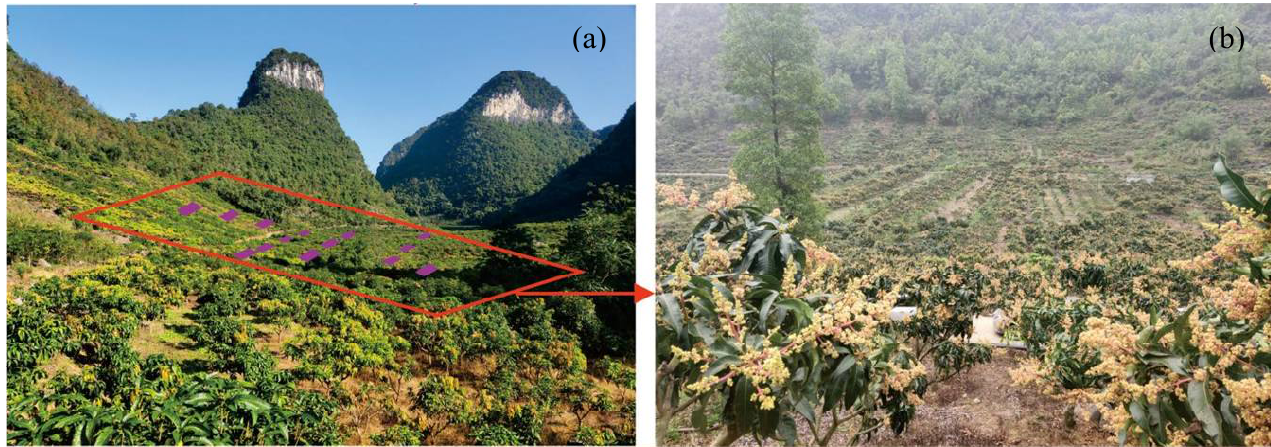
Figure 1. Schematic diagram of the study area. The purple blocks in the image (a) are the sampling sites in the different geomorphic parts (depressions and non-depressions) in the study area; the image (b) is the view from above the sampling sites.